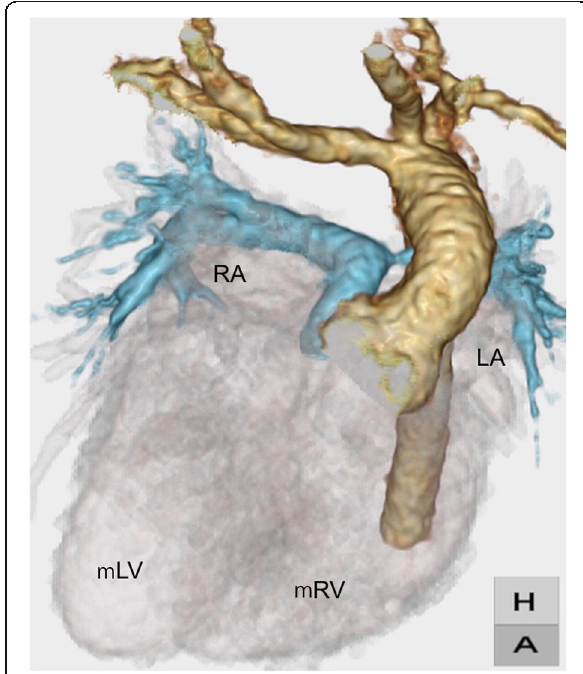
Fig. 1 Three-dimensional computed tomography before initial palliation. LA, left atrium; mRV, morphological right ventricle; mLV, morphological left